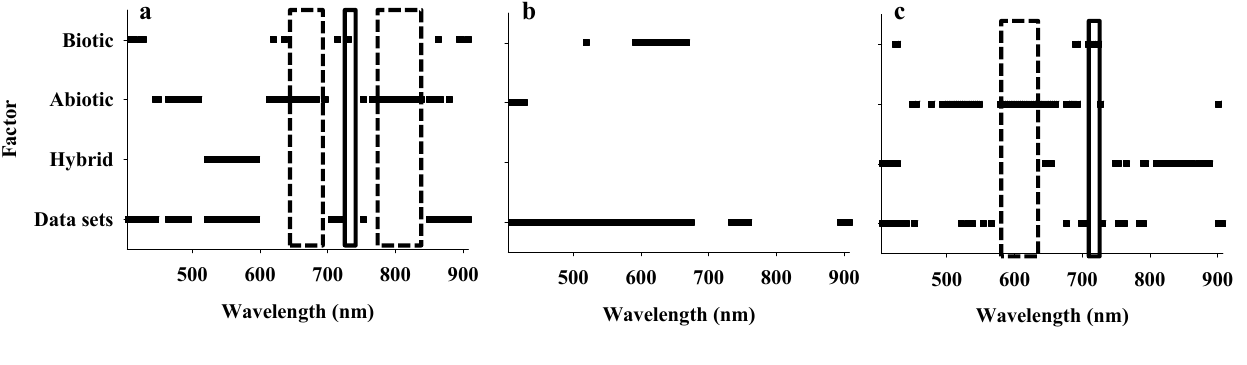
Figure 2. Analysis of variance of nugget ( a ), sill ( b ) and range ( c ) values in 160 spectral bands between 405 and 907 nm in response to 4 treatment factors: (1) difference between data set 1 and 2 (Table 1), (2) difference between hybrid 1 and 2, (3) response to abiotic stress, and (4) response to biotic stress. Horizontal bars represent spectral regions with significant response to either abiotic (dashed) or biotic (non-dashed) stressor at the